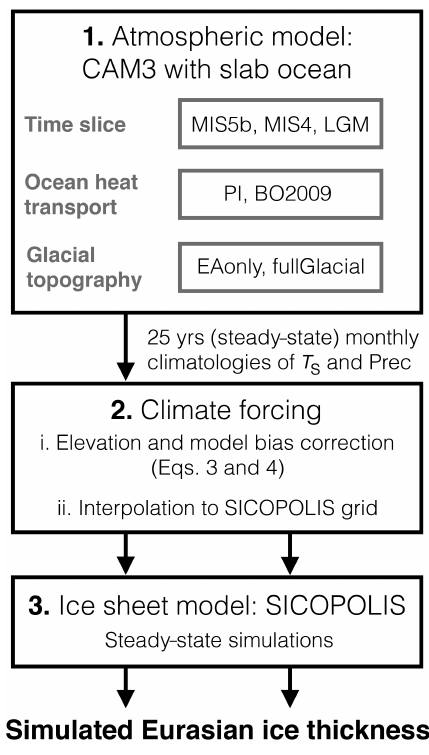
Figure 2. Schematic flow diagram (from top to bottom) of the ex- perimental setup. Step 1: three glacial time slice experiments are carried out with the atmospheric model, using two different repre- sentations of ocean heat transport and glacial topography. Step 2: monthly climatologies of surface temperature ( T s ) and precipita- tion (Prec) are used to create the climate forcing fields which are interpolated to the ice-sheet model grid. Step 3: steady-state ice- sheet model simulations are carried out to obtain the ice thickness in Eurasia. A more detailed description of the experimental setup is provided in the main